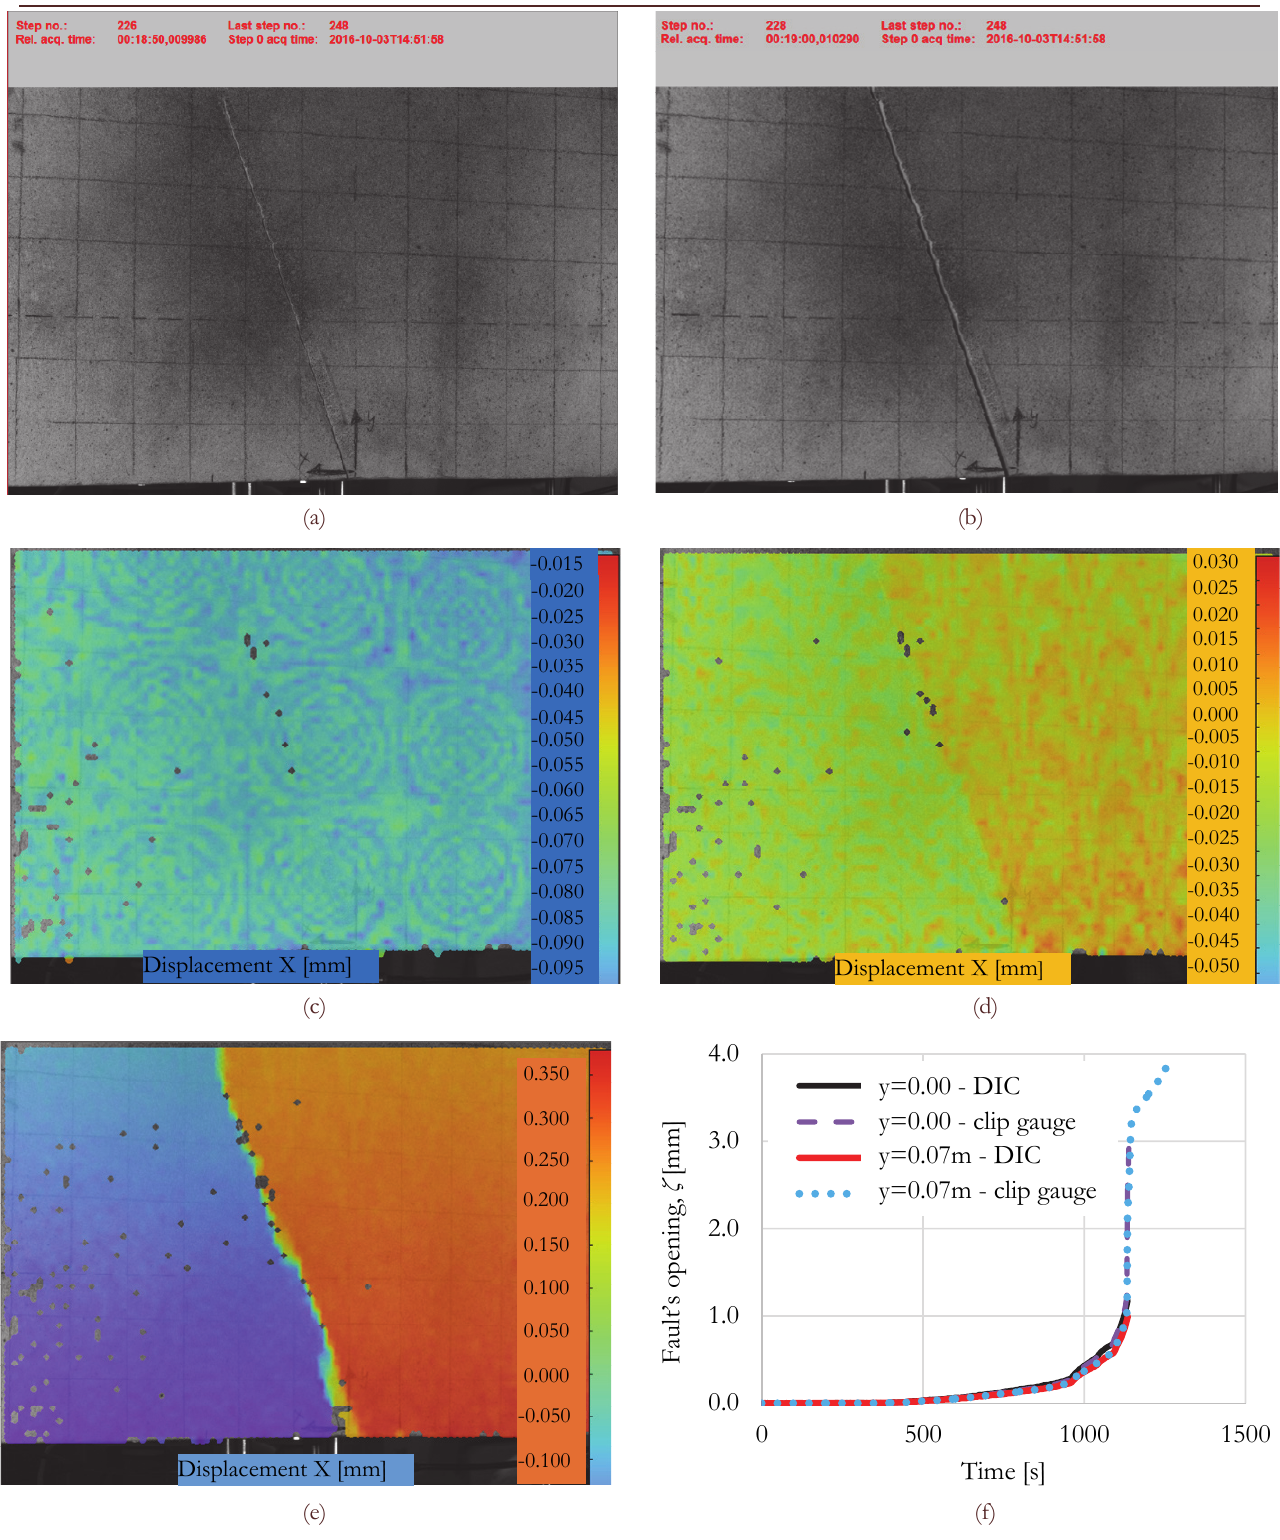
Figure 6: (a) (b) Typical view of the restored epistyle as it seen by the two cameras of the DIC system while failure is impending; (c) The contours of the axial displacement of the epistyle at time instants (c) t=10s; (d) t=405s; and (e) t=1085s; (f) The time variation of the opening of the fault as extracted by the DIC system and by the two clip